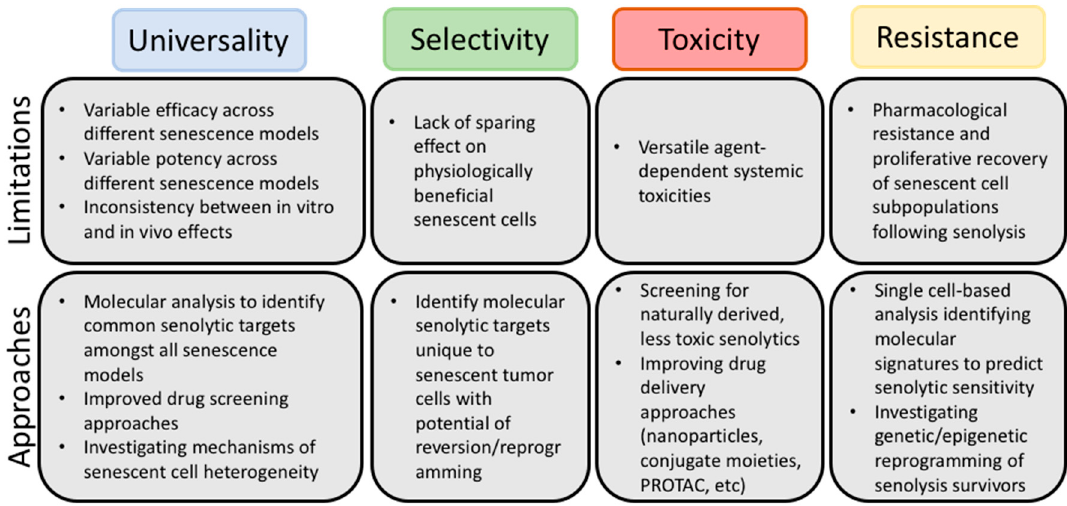
Figure 1. Limitations of current senolytics and potential approaches for circumvention. Although senolytic agents have shown promise as adjuvant cancer therapies preclinically, careful review of the literature has elucidated common limitations. The above figure outlines four outstanding issues with current senolytics, defines these issues, and summarizes the approaches that may mitigate or circumvent these issues, as outlined in detail in Section 3.